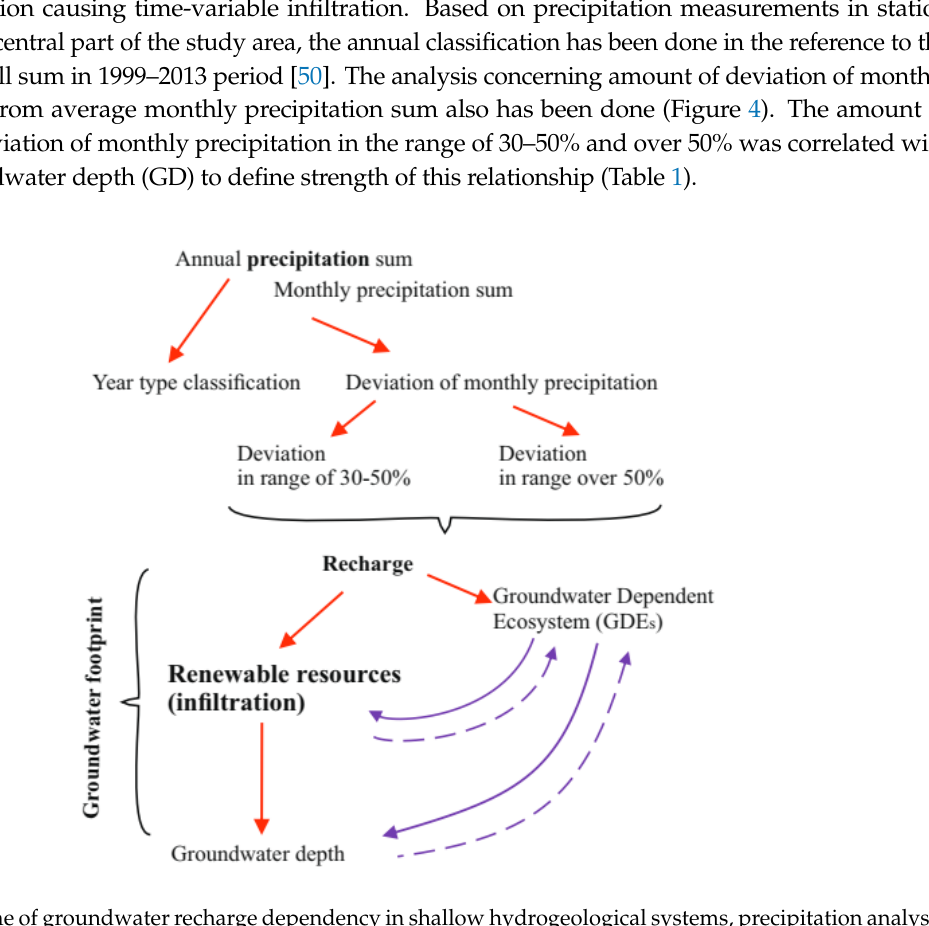
Figure 4. Scheme of groundwater recharge dependency in shallow hydrogeological systems, precipitation analysis.